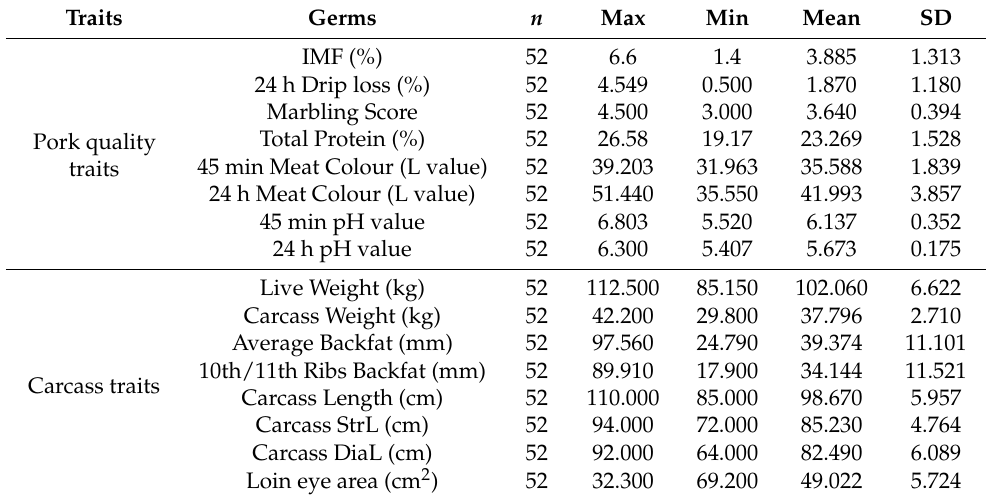
Table 1. Phenotype measure in pork quality and carcass traits for 52 crossbred pigs (Berkshire × AQSW). Traits Germs n Max Min Mean